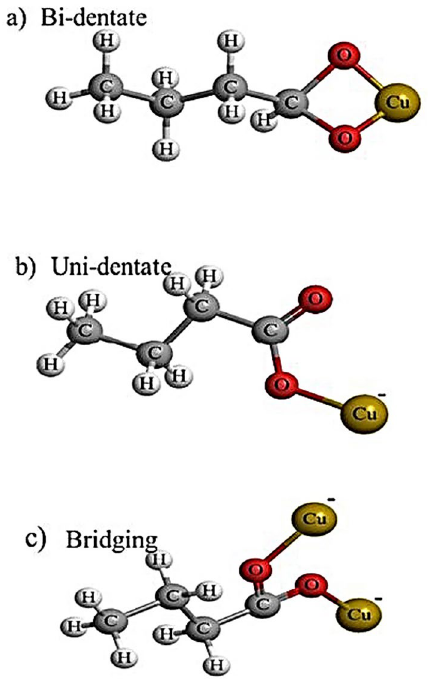
Figure 7. Different ligand attachment style on the surface CuO